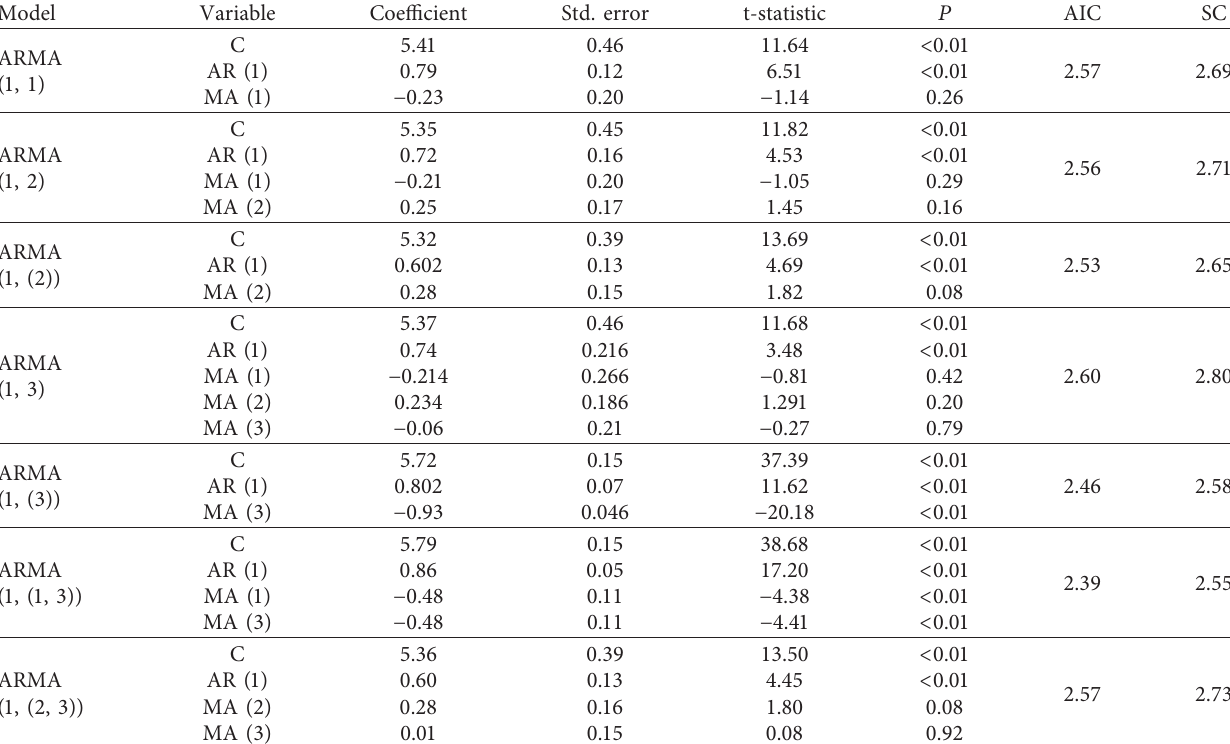
Table 3: Parameter estimates of the tentative models with their AIC and